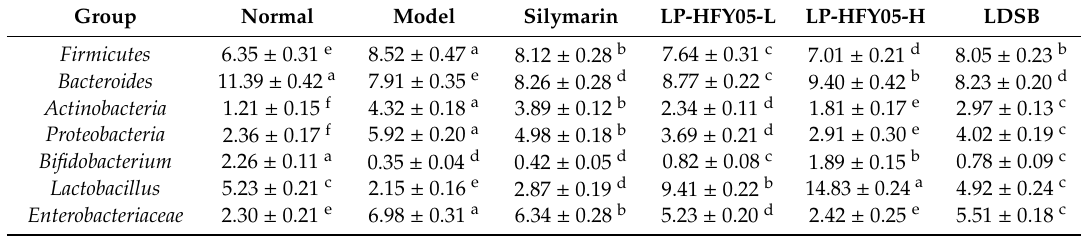
Table 7. Intestinal fecal microbiota of mice in each group ( N = 10, 16 rRNA gene copy number, log 10 / g). Group Normal